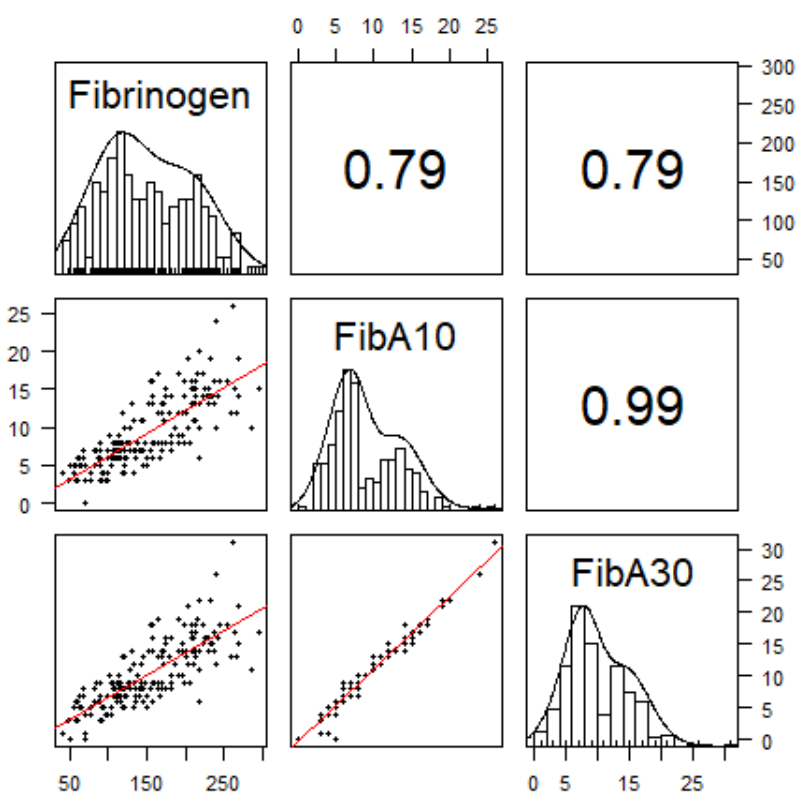
Figure 4. Pearson’s correlation: The panels show the distribution of fibrinogen measurements [Clauss’ method (mg · dL − 1 )] and its correlation to fibrin polymerization (mm) at 10 min (FibA10) and 30 min (FibA30) using all in parallel performed measurements ( n = 193). Correlation coefficients were 0.79 between fibrinogen concentrations and FibA10 as well as FibA30 and 0.99 between FibA10 and FibA30.